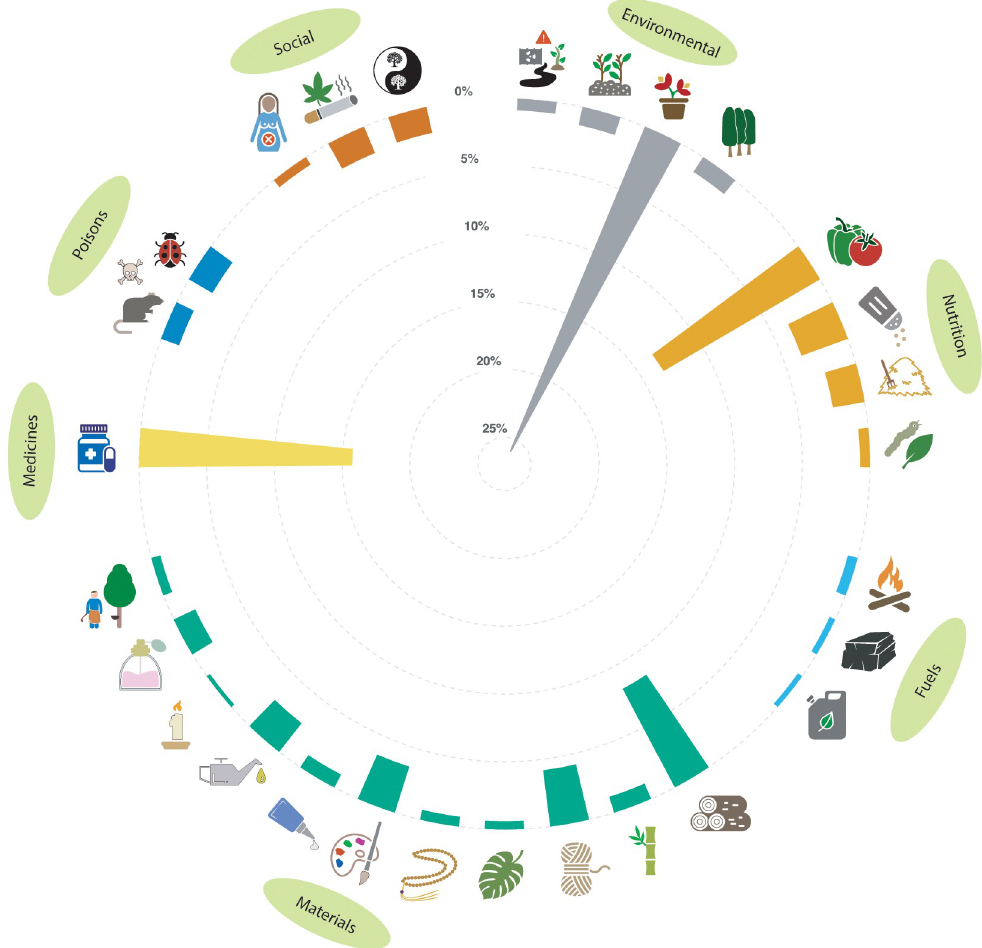
Fig 1. Proportion of plant-use records per category included in the database. From twelve o’clock and clockwise: bioindicators and bioremediators (n = 81), soil improvers (n = 129), ornamental (n = 2464), hedges and shelters (n = 123), human food (n = 1269), food additives (n = 345), vertebrate food (n = 225), invertebrate food (n = 69), fuelwood (n = 70), charcoal (n = 42), biofuels (n = 35), timber (n = 780), stems/cane (n = 115), fibres (n = 397), leaves (n = 58), seeds and fruits (n = 69), tannins and dyestuffs (n = 337), resins and gums (n = 101), lipids (n = 254), waxes (n = 26), scents (n = 165), rubber (n = 65), medicines (n = 1492), vertebrate poisons (n = 133), invertebrate poisons (n = 189), antifertility agents (n = 61), smoking materials and drugs (n = 199), symbolism, magic and inspiration (n = 185).